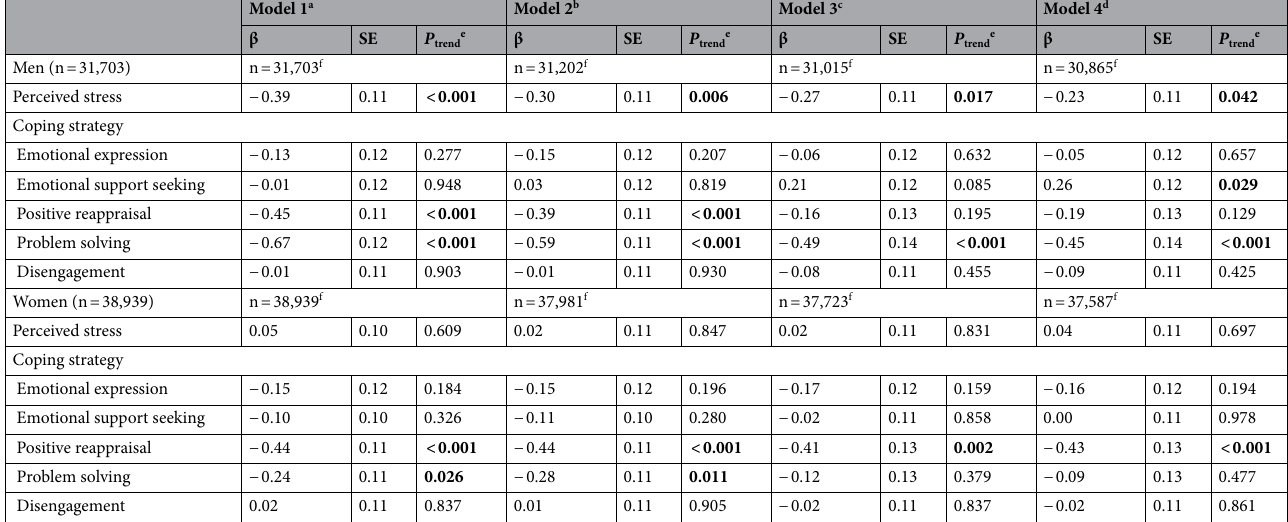
Table 3. Multiple regression analyses of the associations of perceived stress and coping strategies with eGFR by gender. Abbreviations: β, regression coefficient; SE, standard error. The multiple regression models included the eGFR as a dependent variable and each perceived stress and coping strategy as the main independent variables (ordinal variables). The unit of β and SE is ml/min/1.73 m 2 . Bold font represents P < 0.05. a Adjusted for age and area. b Additionally adjusted for drinking, smoking, physical activity, sleeping hours, energy intake, and body mass index. c Additionally adjusted for perceived stress and all coping strategies. The R 2 value was 0.13 for men and 0.12 for women. d Additionally adjusted for the history of hypertension, diabetes, and hyperlipidemia. The R 2 value was 0.14 for men and 0.13 for women. e Represents the statistical significance of β. f Denotes the number of subjects analyzed in the model including perceived stress as a main independent